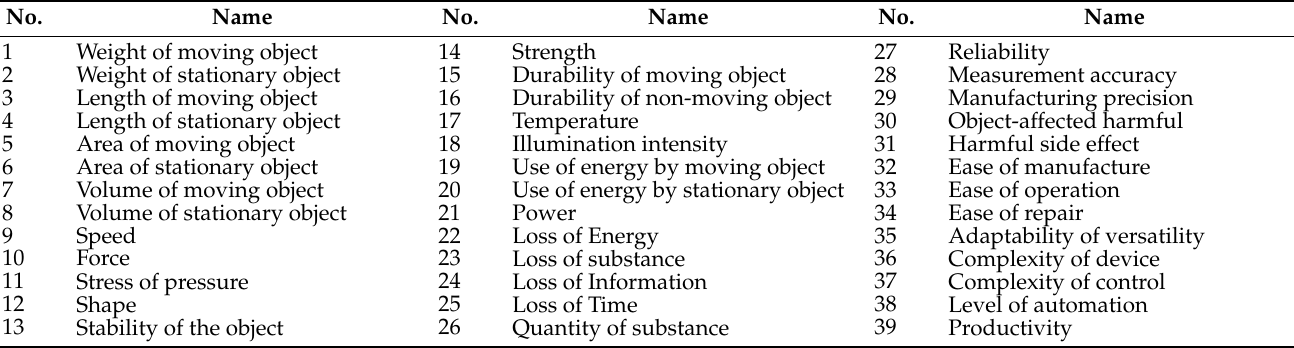
Table A1. The 39 engineering